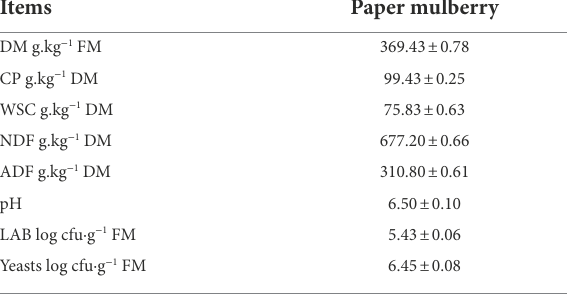
TABLE 2 Chemical composition of fresh paper